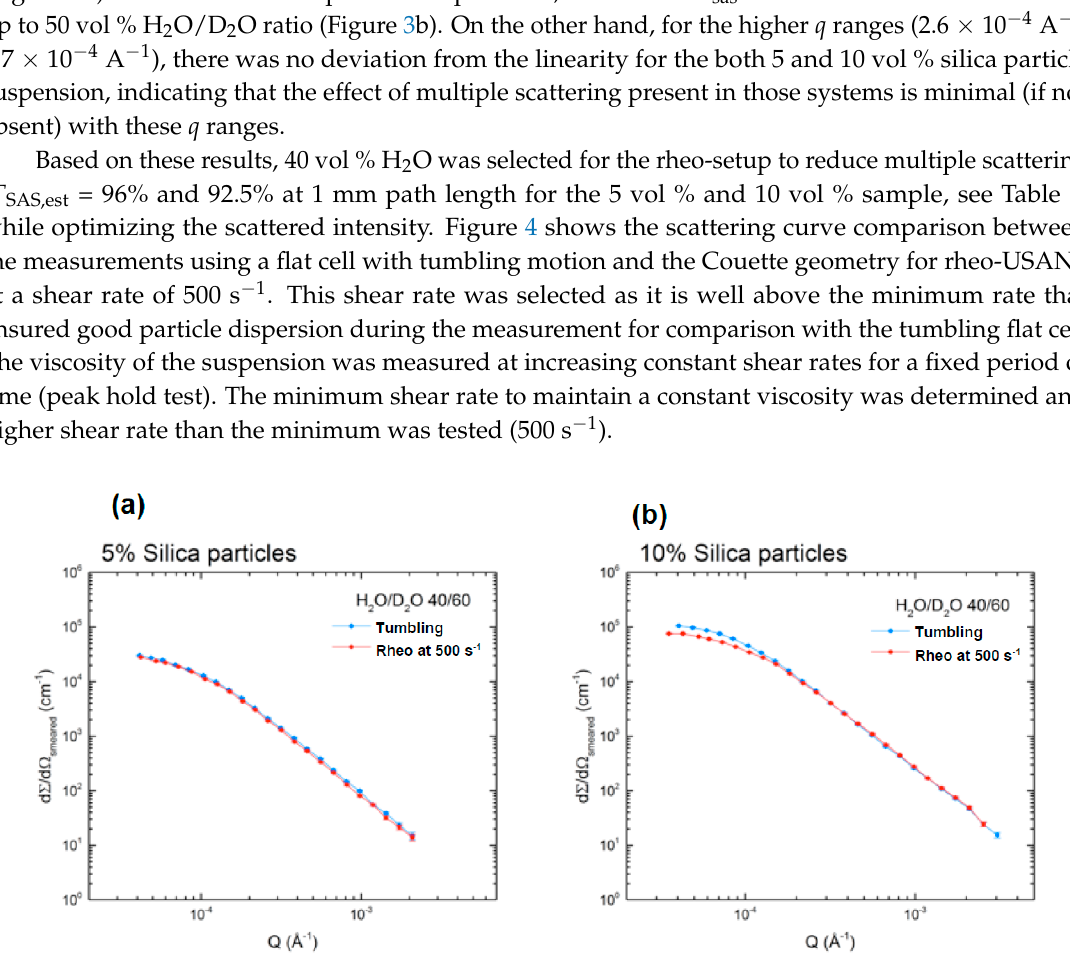
Figure 4. Scattering curve comparison between measurements using a flat cell with tumbling motion and Couette geometry for rheo-USANS at 500 s − 1 shear rate. ( a ) 5 vol % SiO 2 , 40 vol % H 2 O in H 2 O/D 2 O ratio, pH10; ( b ) 10 vol % SiO 2 , 40 vol % H 2 O in H 2 O/D 2 O ratio, pH10.